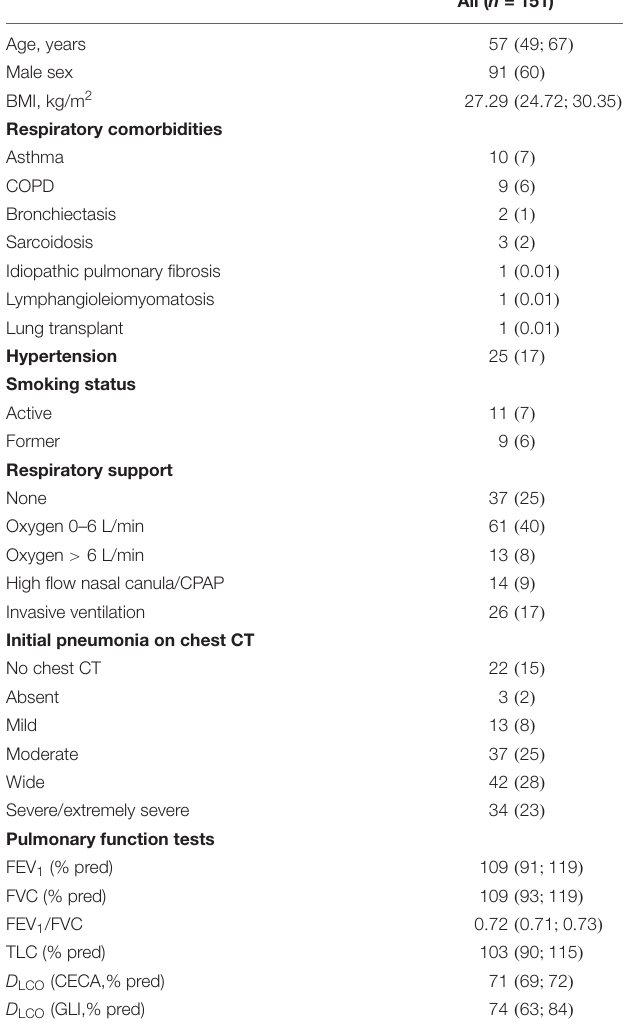
TABLE 1 | Patients’